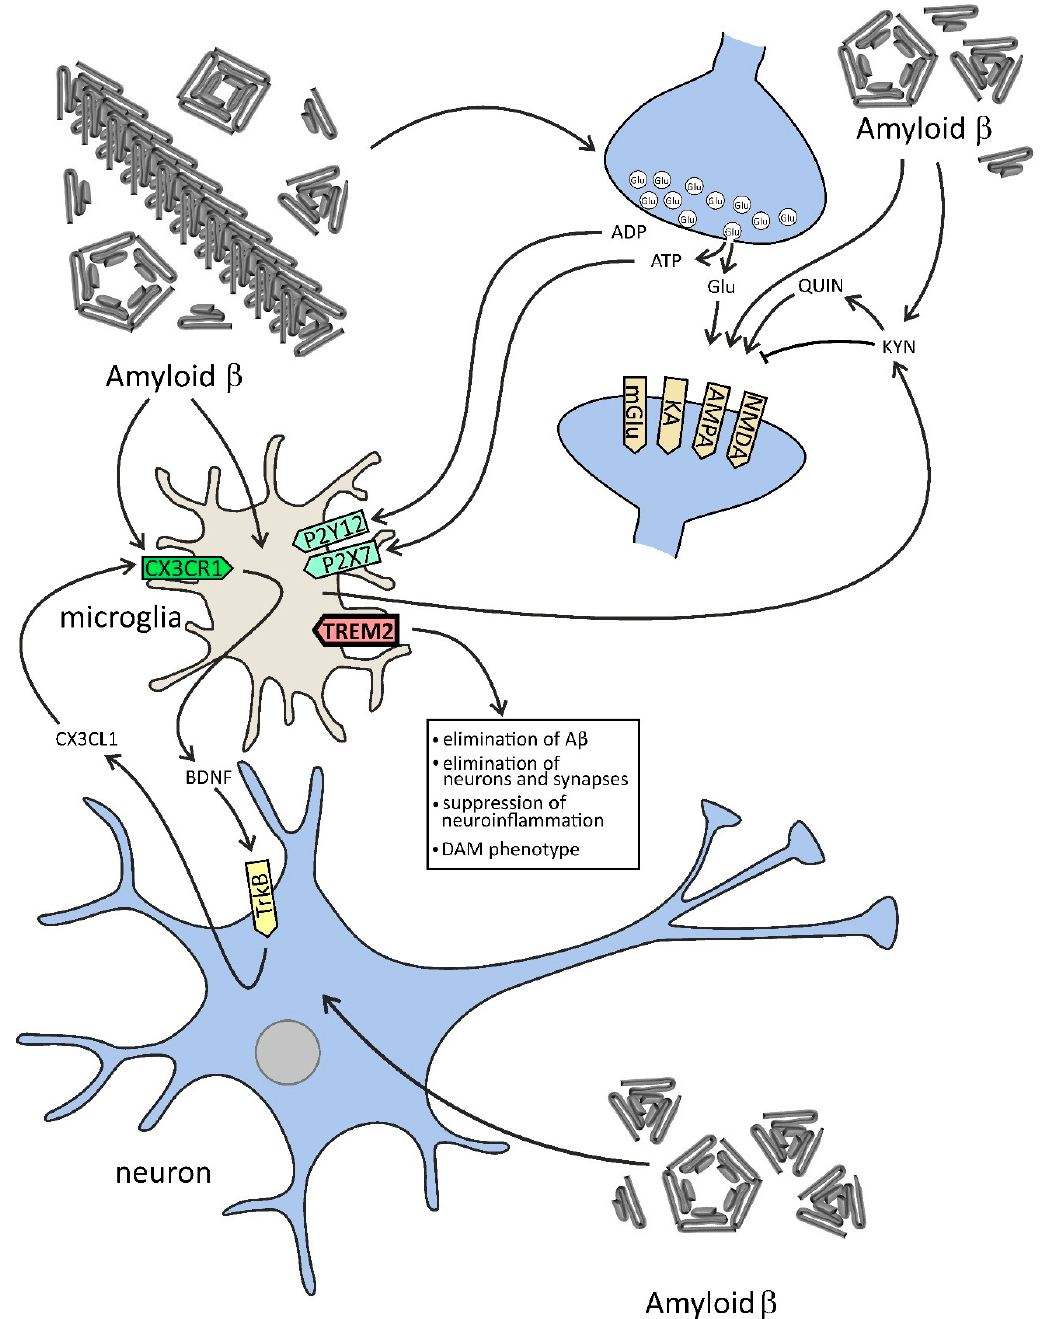
Figure 2. The effect of A β on selected components of microglia–neuron dialogue in AD. In this figure, the effect of A β on neurons and microglia is demonstrated. A β peptides evoke the release of glutamate and ATP from neurons, which activates neuronal NMDA and other receptors and in microglial cells exerts a significant effect on purinergic receptors. A β -activated microglia change tryptophan metabolism toward the kynurenine (KYN) pathway, which leads to an increase in the level of KYN and other molecules affecting glutamatergic signaling, such as quinolinic acid (QUIN), which may evoke excitotoxicity. Microglia concomitantly release neurotrophic factors, among them brain-derived neurotrophic factor (BDNF), leading to stimulation of tropomyosin receptor kinase B (TrkB) and release of chemokine (C-X3-C motif) ligand 1 (CX3CL1). The proper function of microglia is dependent on the TREM2 (triggering receptor expressed on myeloid cells 2) receptor, which is engaged in the clearance of A β and other pathological proteins, but also in the elimination of neurons and synapses, and in the suppression of neuroinflammation. TREM2 is also responsible for the switch of microglia phe- notype to disease-associated state (disease-associated microglia, DAM).